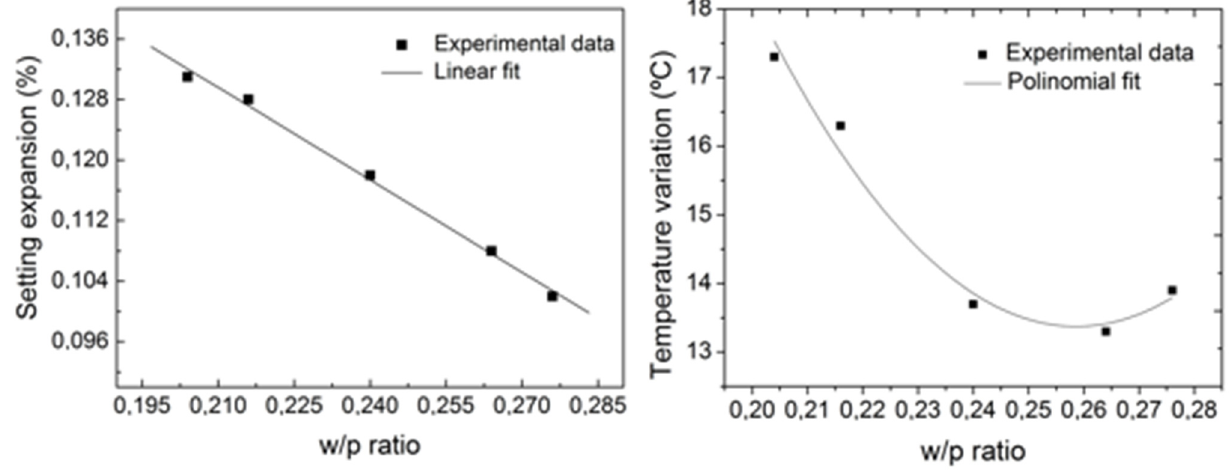
Figure 10. Left: Setting expansion variations; Right: Temperature variations; d uring the setting chemical reaction of dental gypsum type IV, for different w / p ratios. Updated from [133], Copyright The Japanese Society for Dental Materials and Devices,